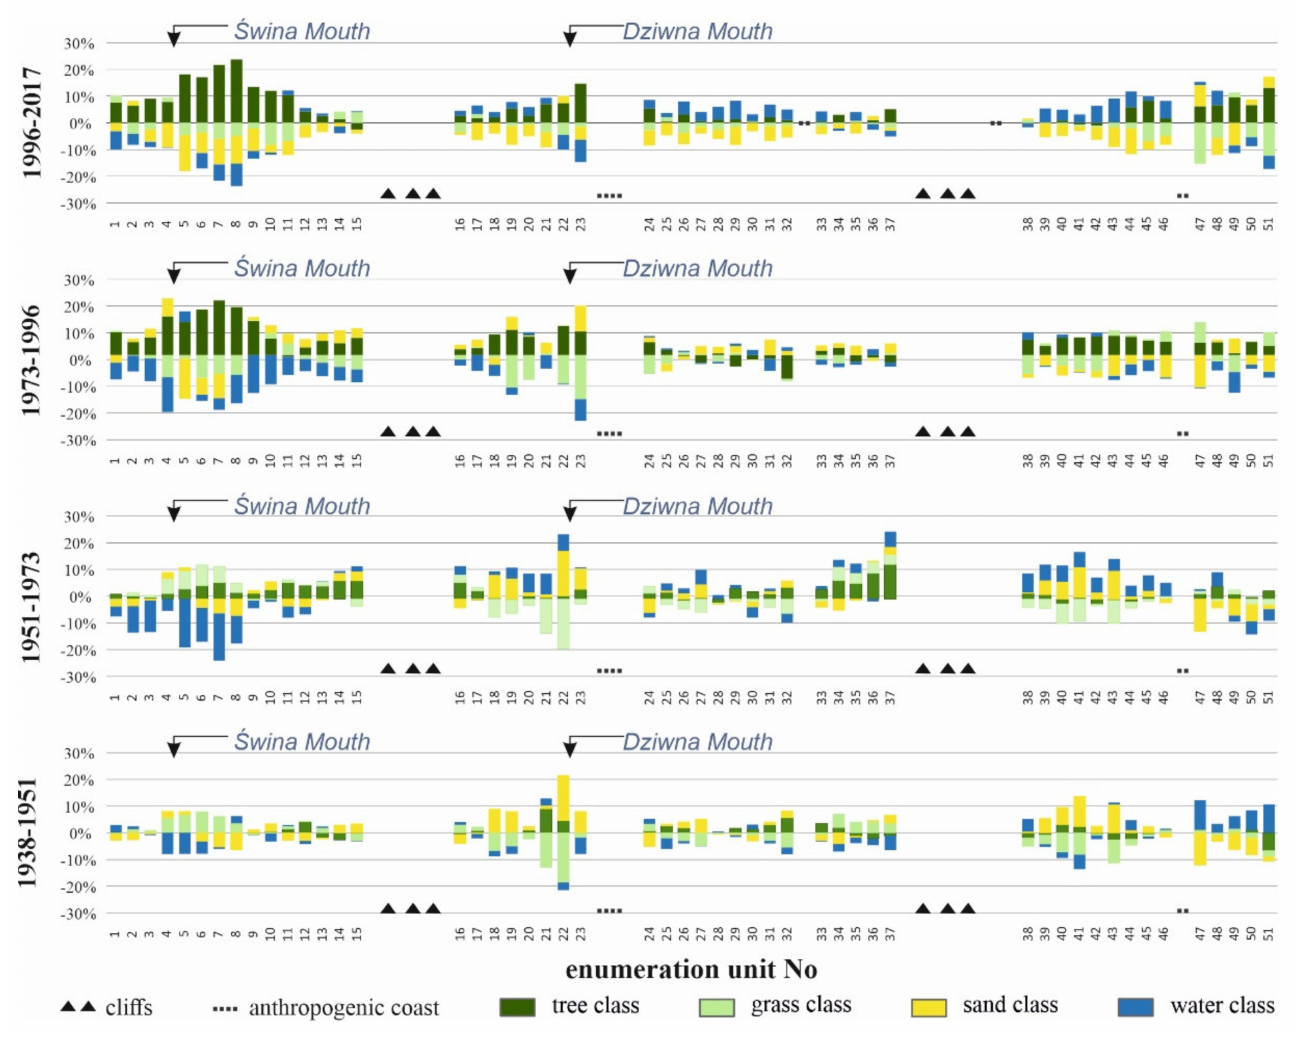
Figure 5. Percentage changes in land